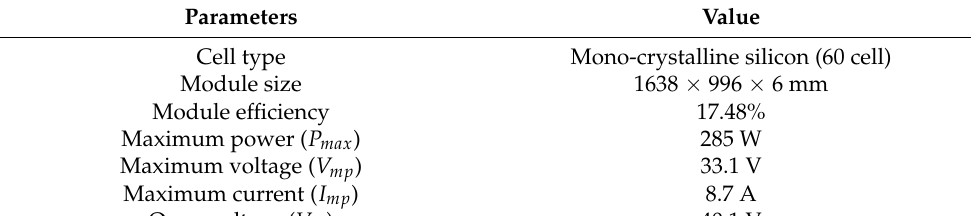
Table 1. PV module specification.